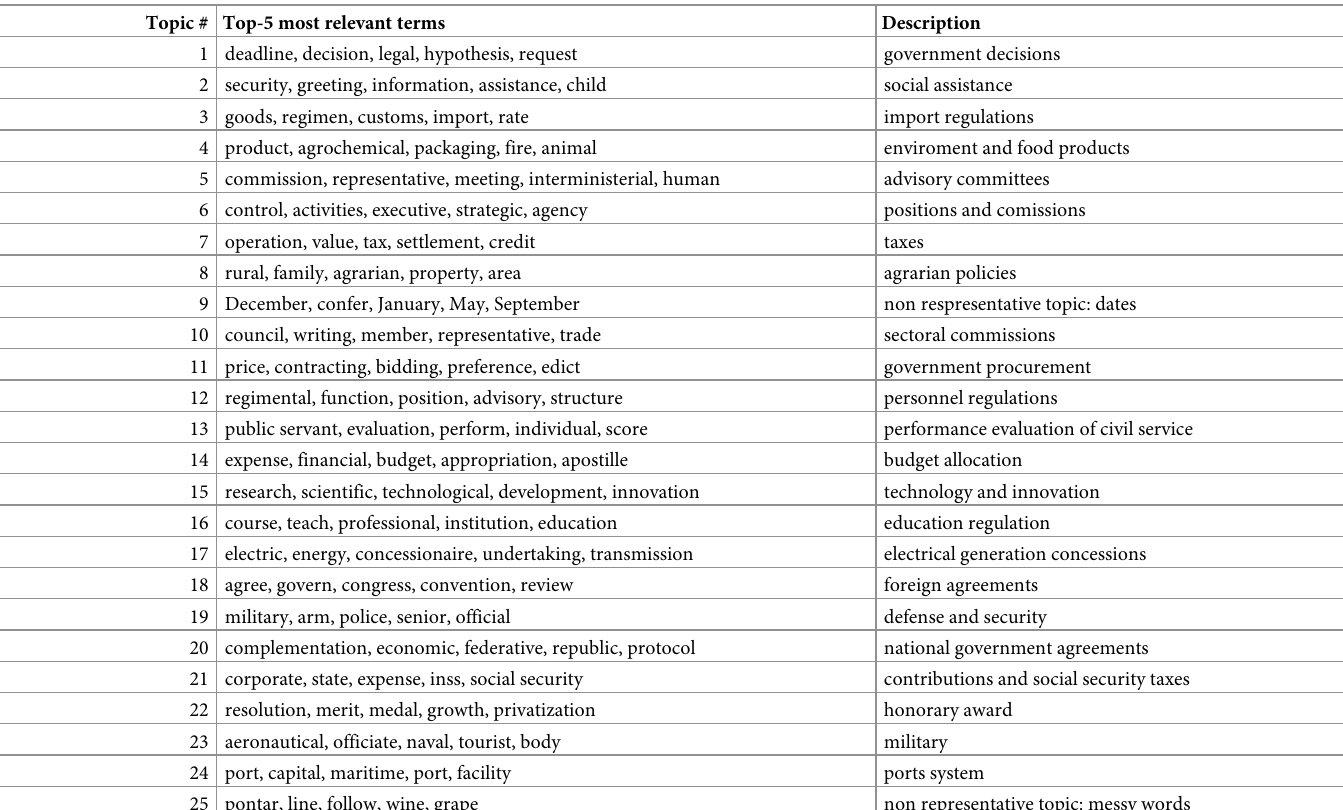
Table 3. Top 5 LDAvis terms for full decree using λ =